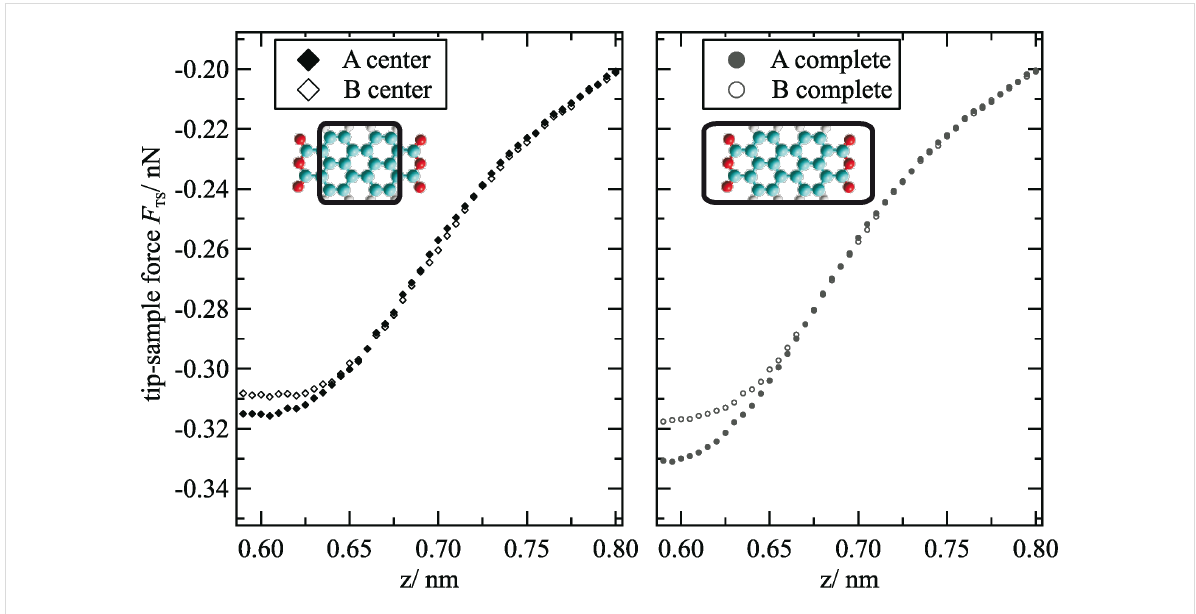
Figure 5: Comparison of force versus distance curves for molecule sites A and B. The forces are averaged for the perylene core (left) and the complete molecule (right) as indicated in the sketches of the molecules. At z distances below 0.65 nm, higher attractive forces are acting at molecule